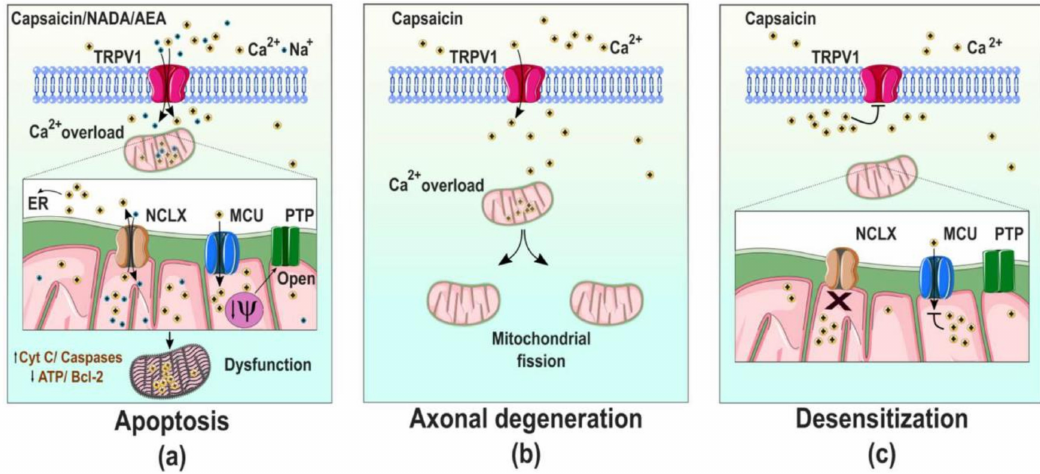
Figure 3. Scheme representing plasmatic TRPV1 actions on mitochondria. ( a ) Prolonged activation of TRPV1 leads to Ca 2 + overload into the mitochondria. This e ff ect triggers